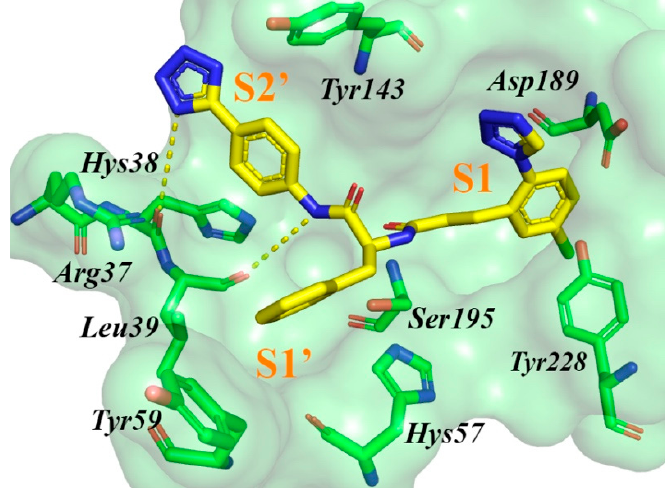
Figure 2. The active site of the FXIa with an inhibitor (PDB ID: 4CRC). Hydrogen bonds are shown as yellow dotted lines.